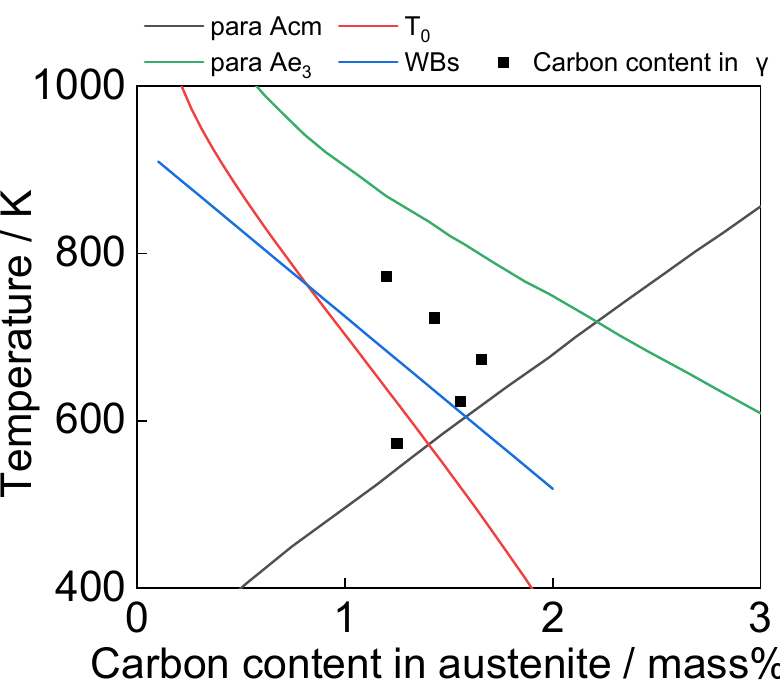
Figure 11. Para equilibrium phase diagram calculated by Thermo-Calc. The WBs line is drawn using the equation suggested by Leach et al. [31]. The maximum carbon concentrations in austenite determined in the current experiment are plotted